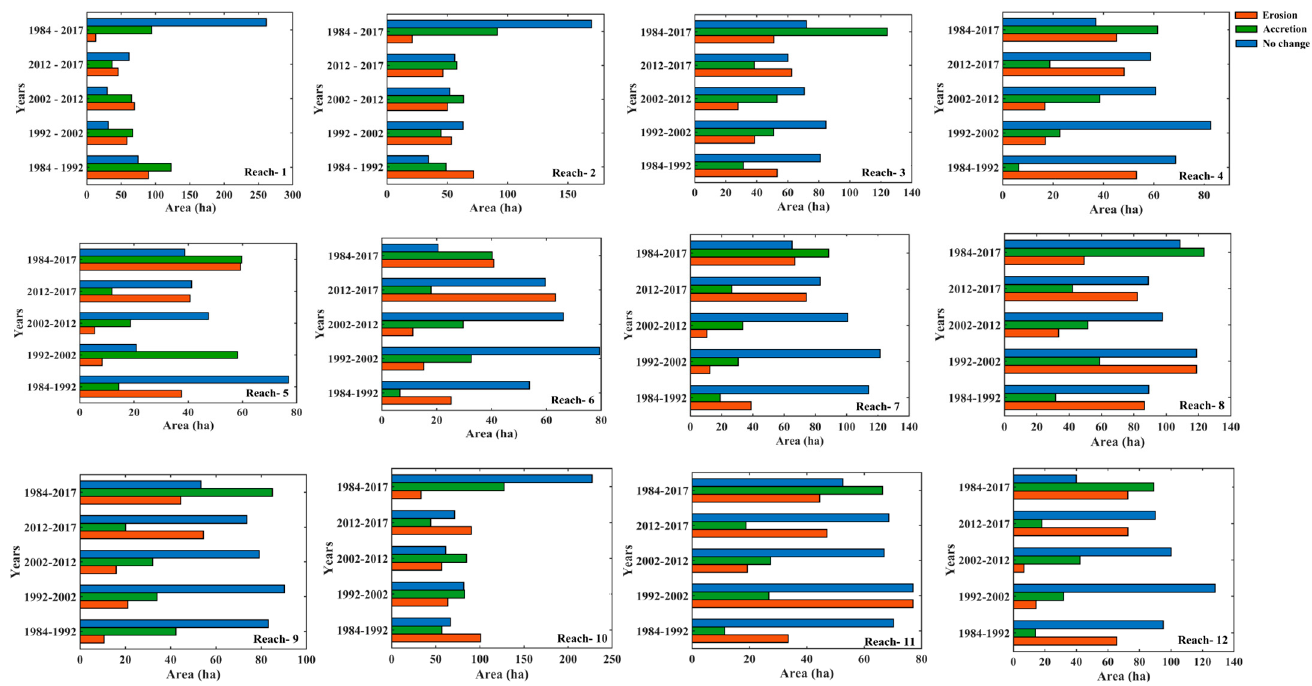
Figure 15. Lateral erosion, accretion, and unchanged area at various reaches along the alluvial plains of the Barak River between 1984 and 2017.